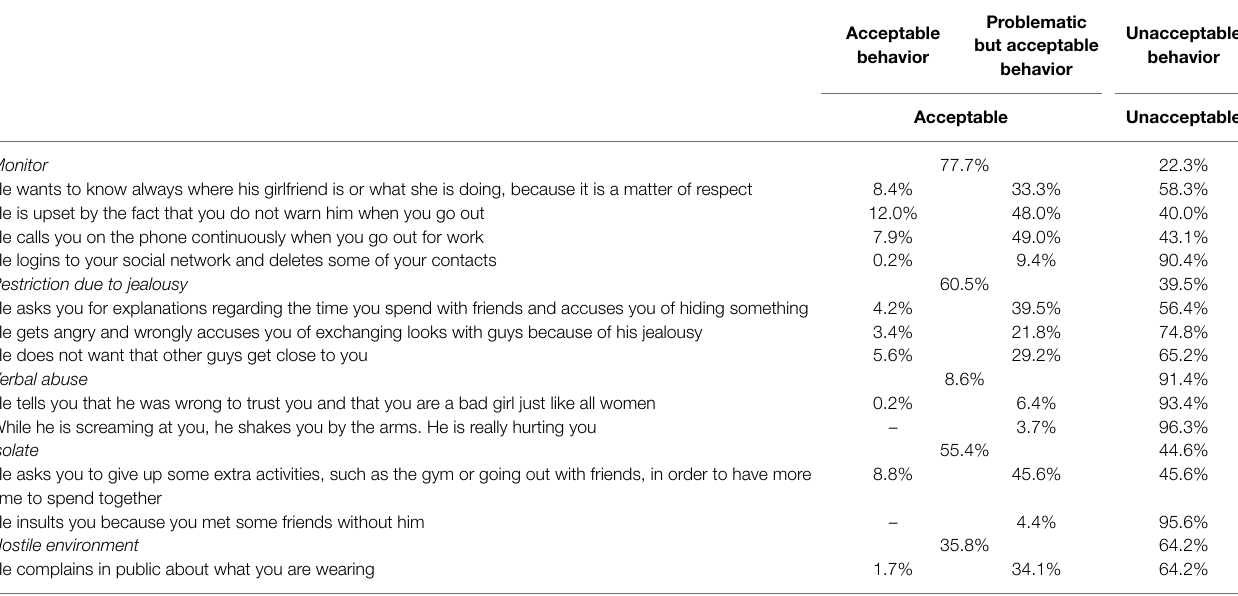
TABLE 3 | Acceptability of psychological aggression in intimate relationships as a function of the five categories of psychologically abusive behaviors (monitor, restriction due to jealousy, verbal abuse, isolate, hostile environment) included in the acceptance for psychological aggression scenarios.